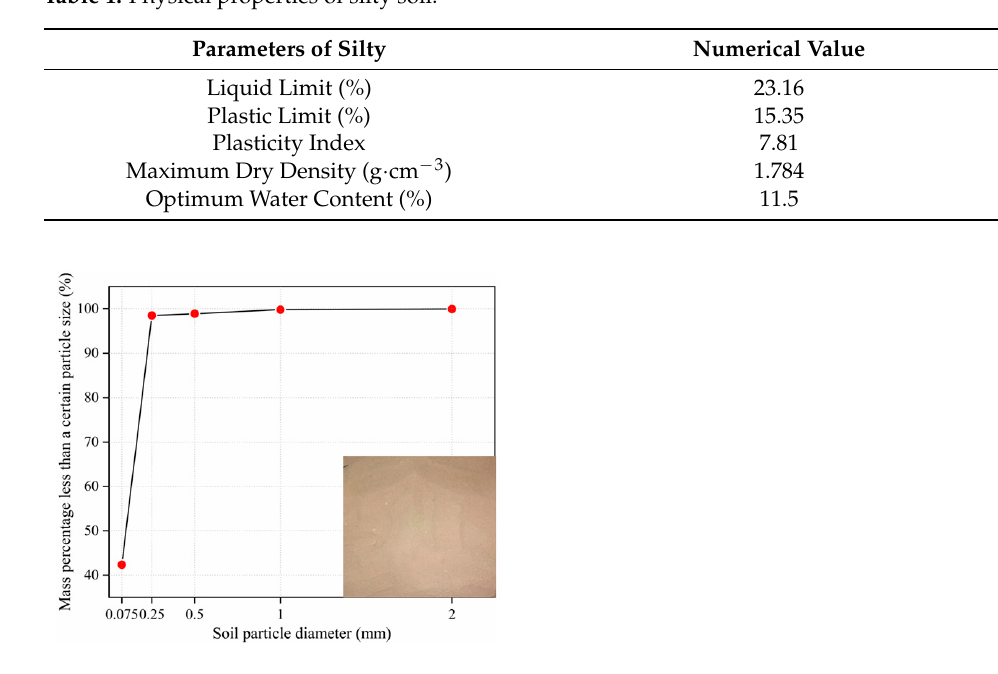
Figure 1. Particle gradation curves of soil samples.